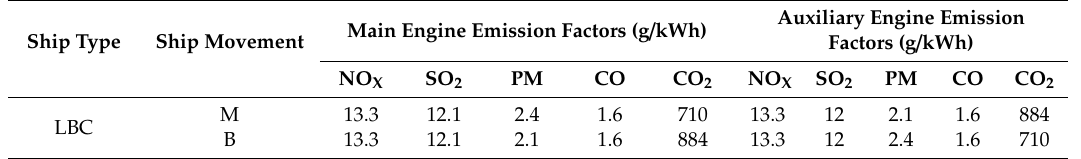
Table 4. Emission factors for container ships in the port of Piraeus